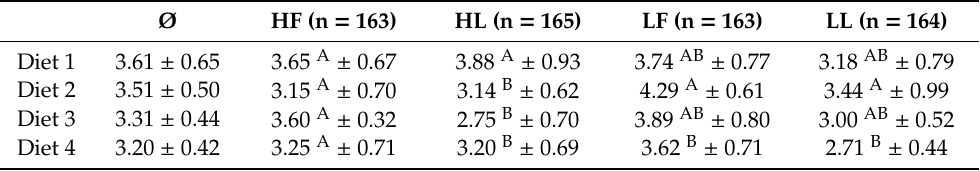
Table 6. Daily feed intake (in kg 88% DM) with a calculated body weight of 100 kg per animal in the four groups and